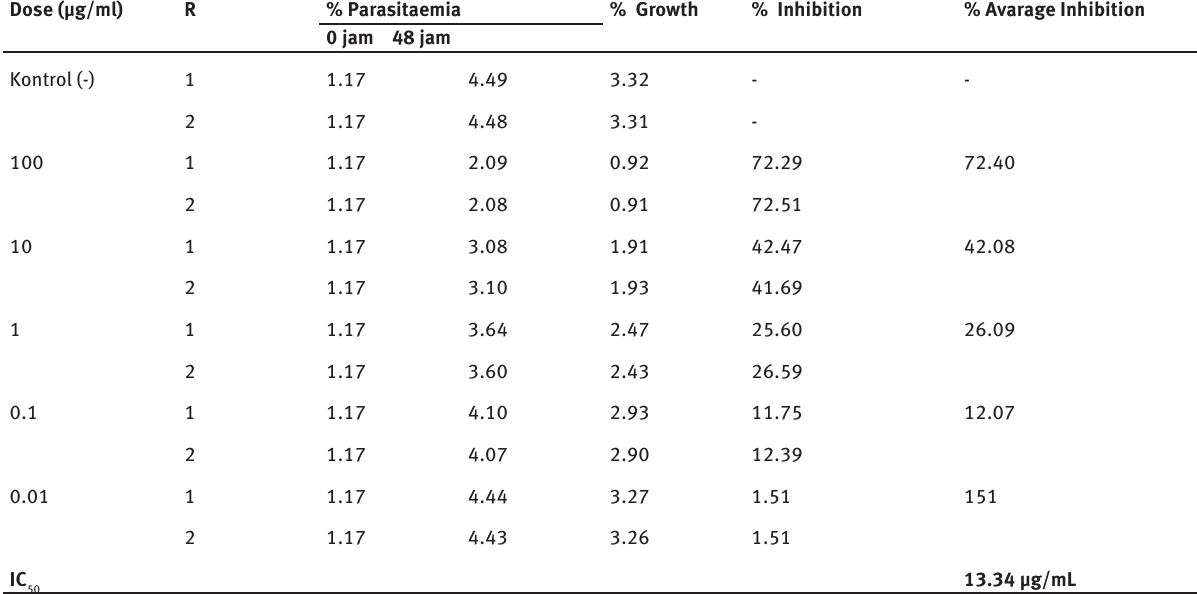
Tabel 4: Antimalarial activity of 3-hydroxystigmast-5-en-7-one against P. falciparum 3D7. Dose